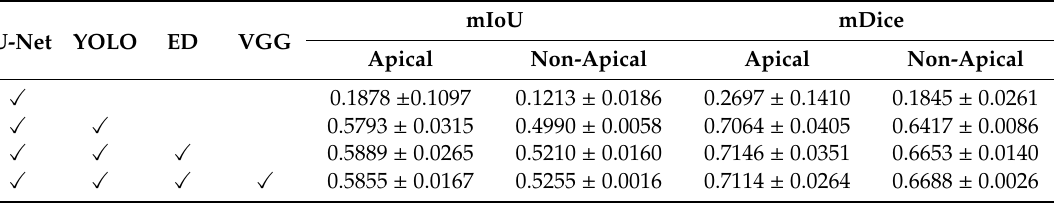
Table 4. Segmentation evaluation by mIoU and mDice for each module combination when divided by the orientation of the heart axis.